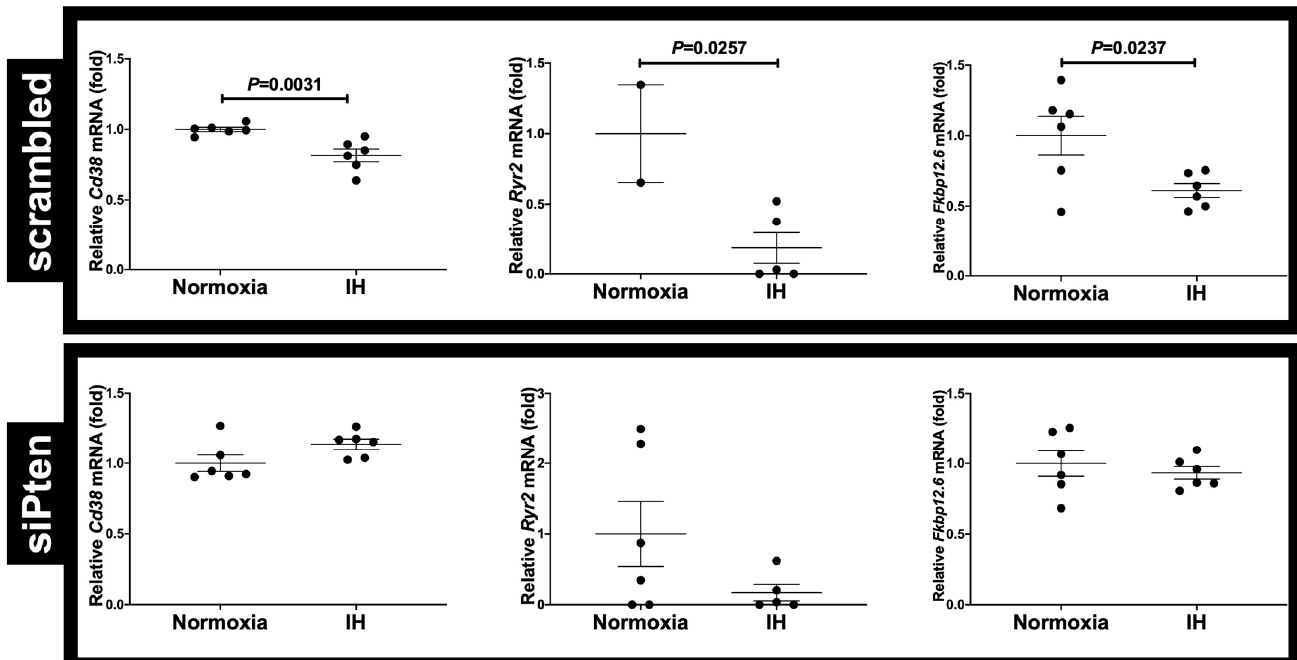
Figure 7. Effects of siPten on the IH ‐ induced gene expression of Cd38 , Ryr2 , and Fkbp12.6 . SiPten and scrambled RNA (control) were transfected into H9c2 cardiomyocytes, which in turn were subjected to IH or normoxia for 24 h. The mRNA levels of the Cd38 , Ryr2 , and Fkbp12.6 were measured via real ‐ time RT ‐ PCR, with Rig/RpS15 as the endogenous control. The mRNA level exposed to normoxia was set to 1.0. Data are expressed as the mean ± SE of six independent experiments ( n = 6). Student’s t ‐ test was used in statistical analyses.